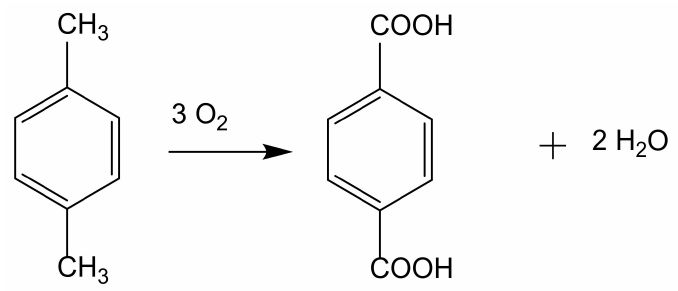
Figure 4. Terephthalic acid production from p -xylene